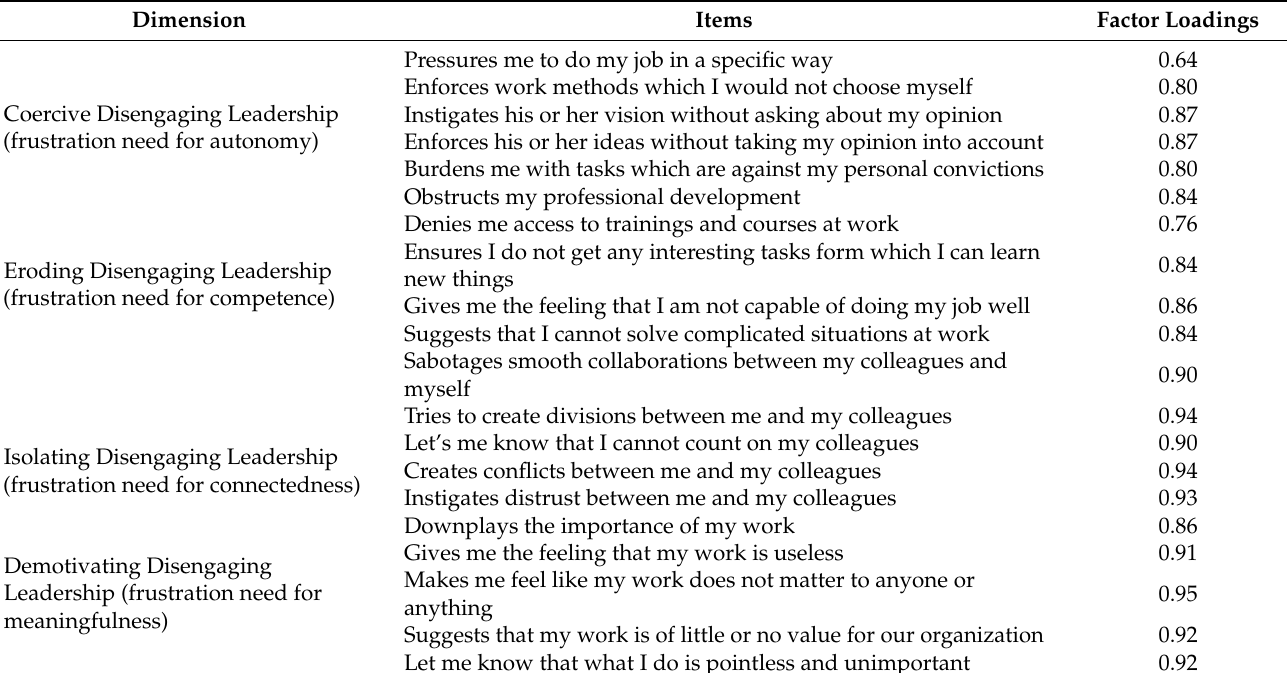
Table 2. Items of the Disengaging Leadership Scale ( N = 400; Model